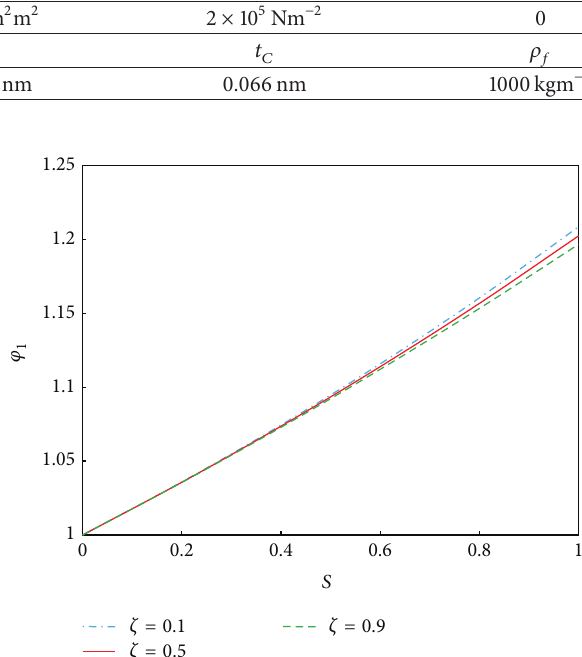
Figure 4: Relationship between ratio 𝜑 1 and dimensionless param- eter 𝑠 for different axial compression ratio 𝜁 .